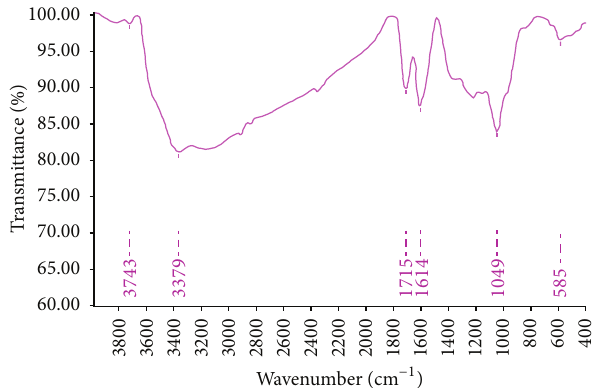
Figure 4: FTIR spectra graph of graphene oxide, showing the presence of different oxygen functionalities.